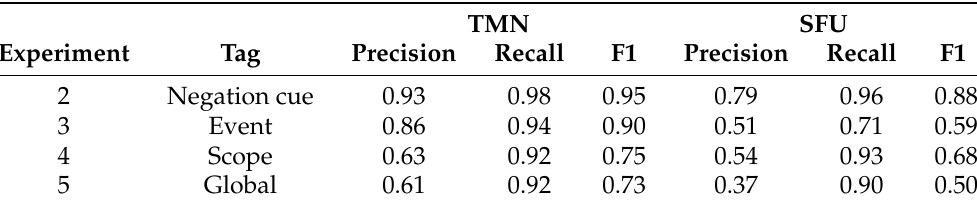
Table 7. Results for negation cue, scope and event identification using the CRF approach on TMN and SFU corpora.